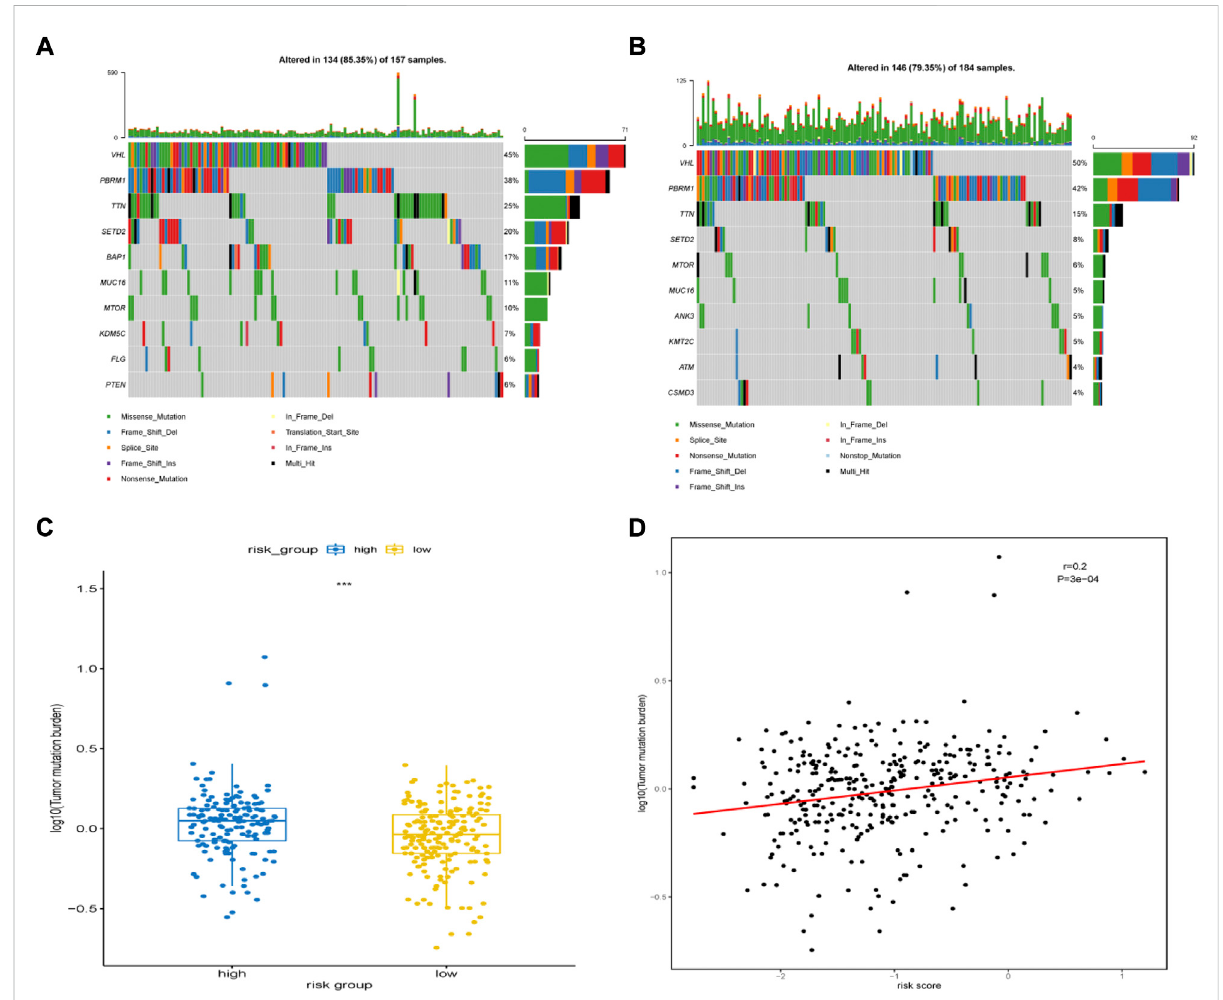
FIGURE 9 Somatic mutation features between high-risk group and low-risk group. (A) The top 10 most signi fi cantly mutated genes in the high-risk group. (B) The top 10 most signi fi cantly mutated genes in the low-risk group. (C) Difference in TMB between the high- and low-risk groups. (D) Correlation between TMB levels with